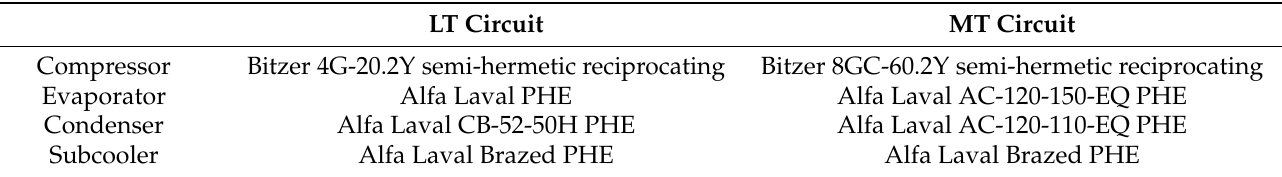
Table 1. Components of the supermarket refrigeration